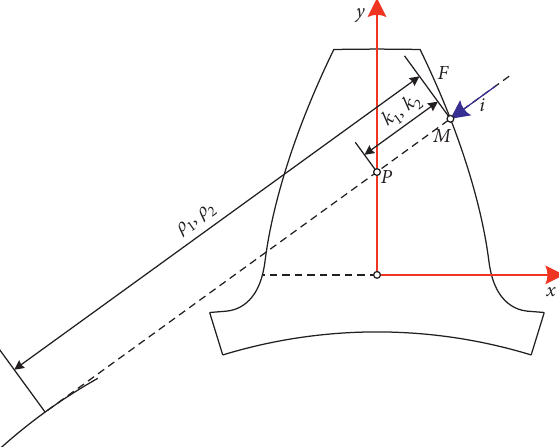
Figure 6: Geometric parameters for local contact deformation